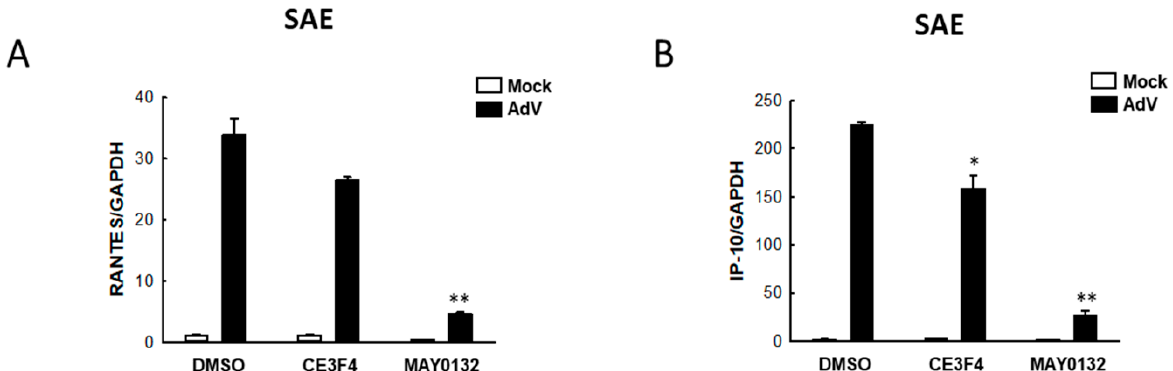
Figure 4. EPAC2-mediated chemokine induction by AdV. ( A , B ) SAE cells in triplicate were mock-infected or infected with AdV at an MOI of 1. At 2 h p.i., cells were treated with DMSO, 10 μ M CE3F4, or 10 μ M MAY0132. At 48 h post-treatment, total RNA was extracted and subjected to qRT-PCR to measure the expression of RANTES ( A ) and IP-10 ( B ). GAPDH was used for normalization. * p < 0.05 and ** p < 0.01, relative to the DMSO-treated and AdV-infected group.